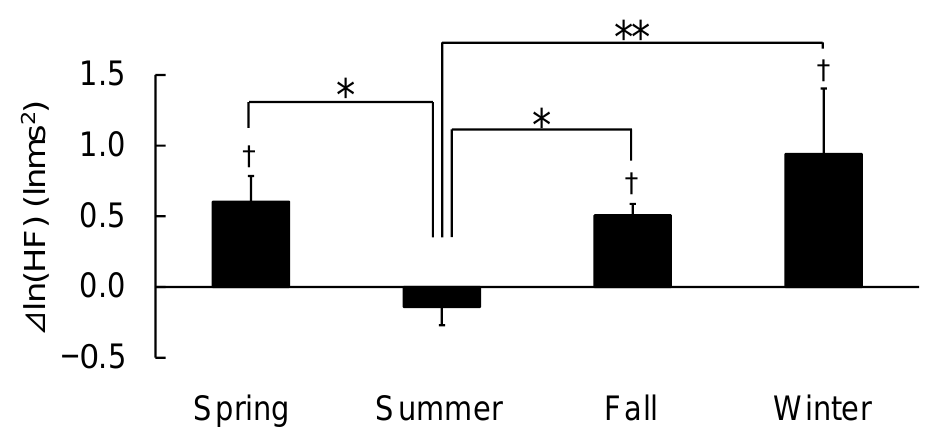
Figure 3. Differences in the changes in ln(HF) between walking in an urban park and a city area according to the four seasons. n = 51 (spring: n = 12, summer: n = 12, fall: n = 20, and winter: n = 7), mean ± standard deviation, †: p < 0.05 using the paired t -test (urban park vs. city area), *: p < 0.05, and **: p < 0.01 using one-way analysis of variance with the post-hoc test (four seasons). The ln(HF) values during walking in an urban park were significantly higher compared to the city walking in spring, fall, and winter [20–22]. However, there was no significant difference in ln(HF) in summer (3.51 ± 0.29 vs. 3.65 ± 0.34 lnms 2 , p > 0.05). Based on these results, there were significant differences in seasonal changes (F(3,47) = 5.397, p < 0.01). Differences in ln(HF) by walking in an urban park were significantly higher in spring, fall, and winter compared with summer (spring: 0.60 ± 0.18 vs. summer: −0.14 ± 0.13, p < 0.05; fall: 0.51 ± 0.08 vs. summer, p < 0.05; and winter: 0.94 ± 0.46 vs. summer, p < 0.01). The ln(LF/HF) during walking in an urban park was signif- icantly lower compared to walking in the city area in spring and fall [20,21]. However, there was no significant difference with respect to ln(LF/HF) between participants who walked in an urban area and those who walked in a city area in summer (1.91 ± 0.15 vs. 1.74 ± 0.20, p > 0.05) and winter [22]. Therefore, a significant difference was observed in seasonal changes (F(3,47) = 5.979, p < 0.01). Differences in ln(LF/HF) by walking in an ur- ban park were significantly lower in a city area in spring, fall, and winter compared with summer (spring: −0.42 ± 0.11 vs. summer: 0.17 ± 0.12, p < 0.01; fall: −0.39 ± 0.09 vs. summer, p < 0.01; and winter: −0.38 ± 0.20 vs. summer, p < 0.05).